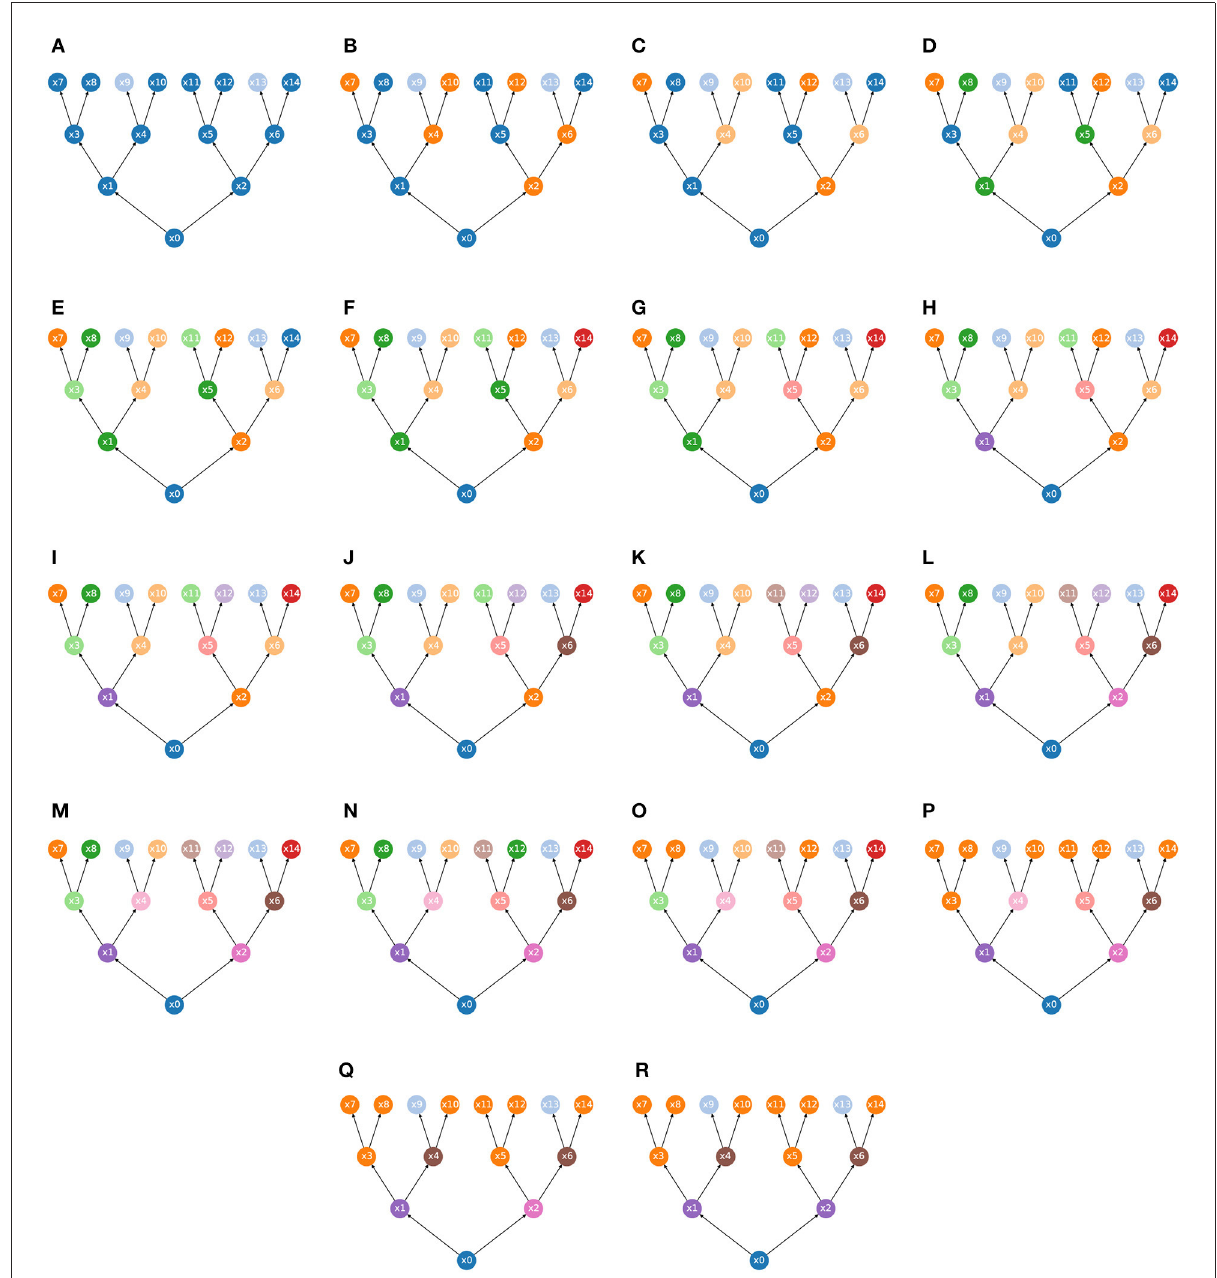
FIGURE10 (A) Labeled automaton with labefigure/ling function h = h 0 ; same colored states belong to the figure/same equivalence class. (B–Q) Updating h by Algorithm 1 through splitting and merging of the labels. (R) Labeled automaton with the labeling function h that is the minimal sufficient refinement of h 0